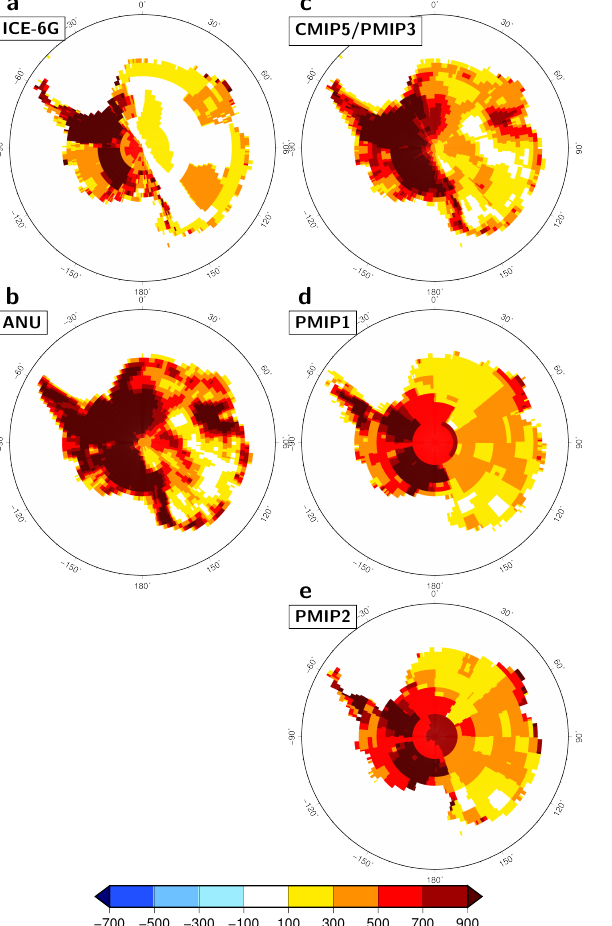
Figure 4. Difference in surface elevation (m) of Antarctica at the LGM compared to the present day from the (a) ICE-6Gv.2, (b) ANU reconstructions, and for (c) the CMIP5/PMIP3 compos- ite compared to the ice sheets used in (d) PMIP1 and (e) PMIP2. The GLAC-1a reconstruction for Antarctica is identical to that of ICE-6G, and is therefore not shown.